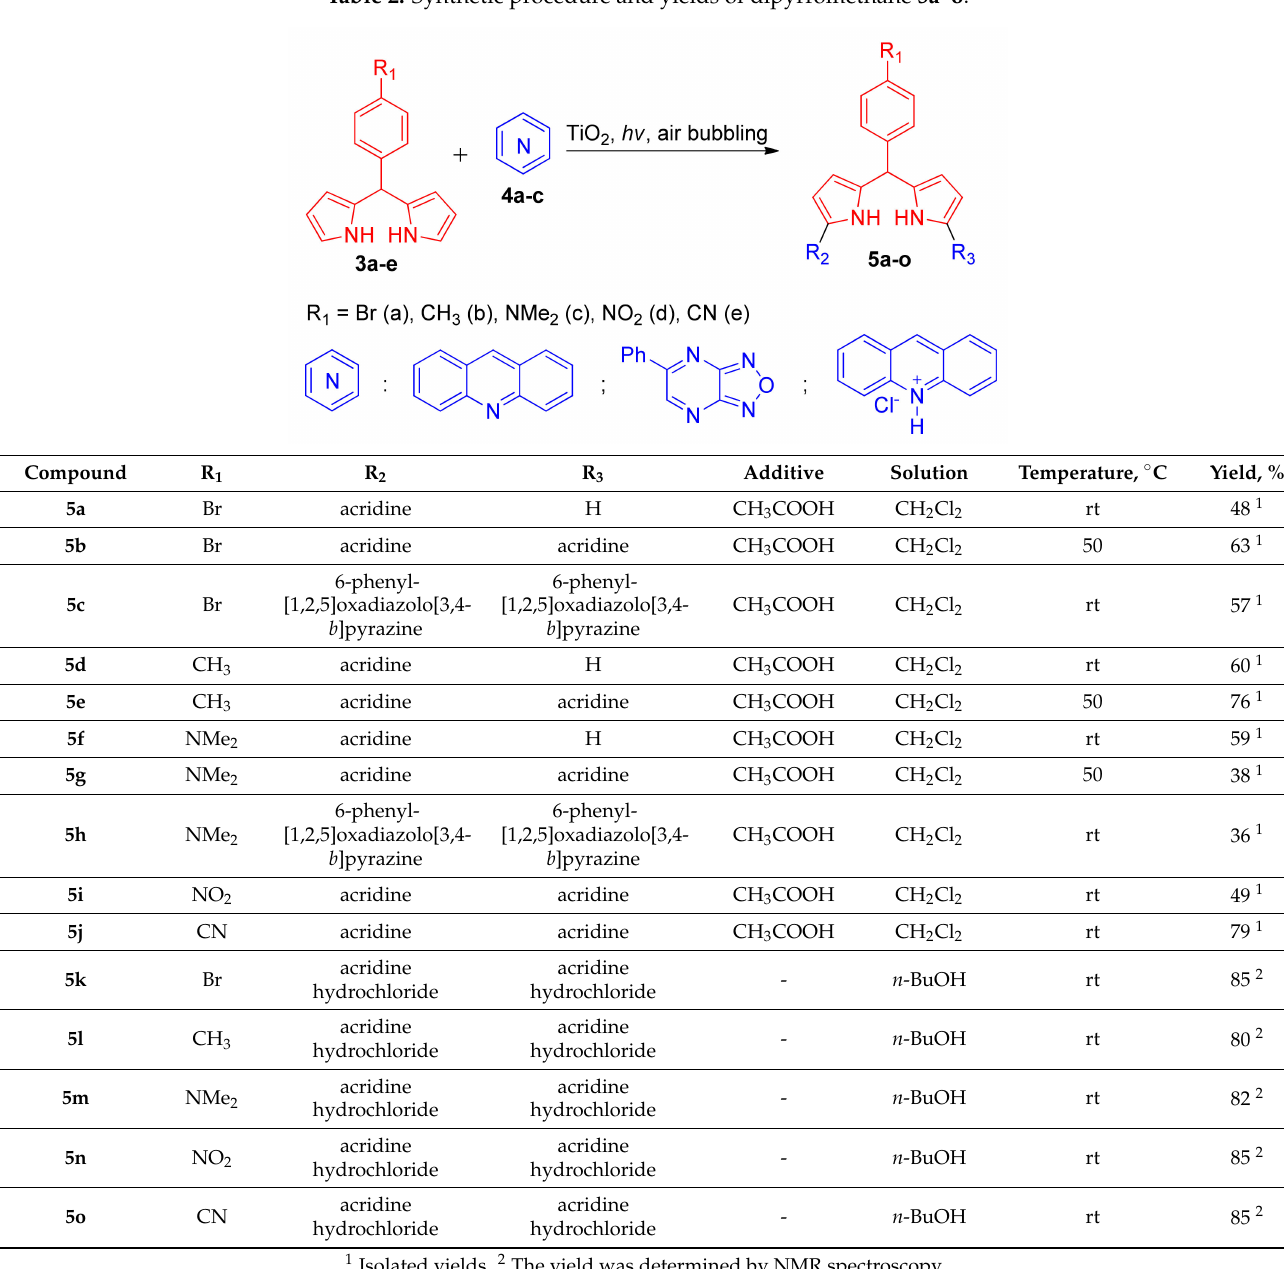
Table 2. Synthetic procedure and yields of dipyrromethane 5a – o